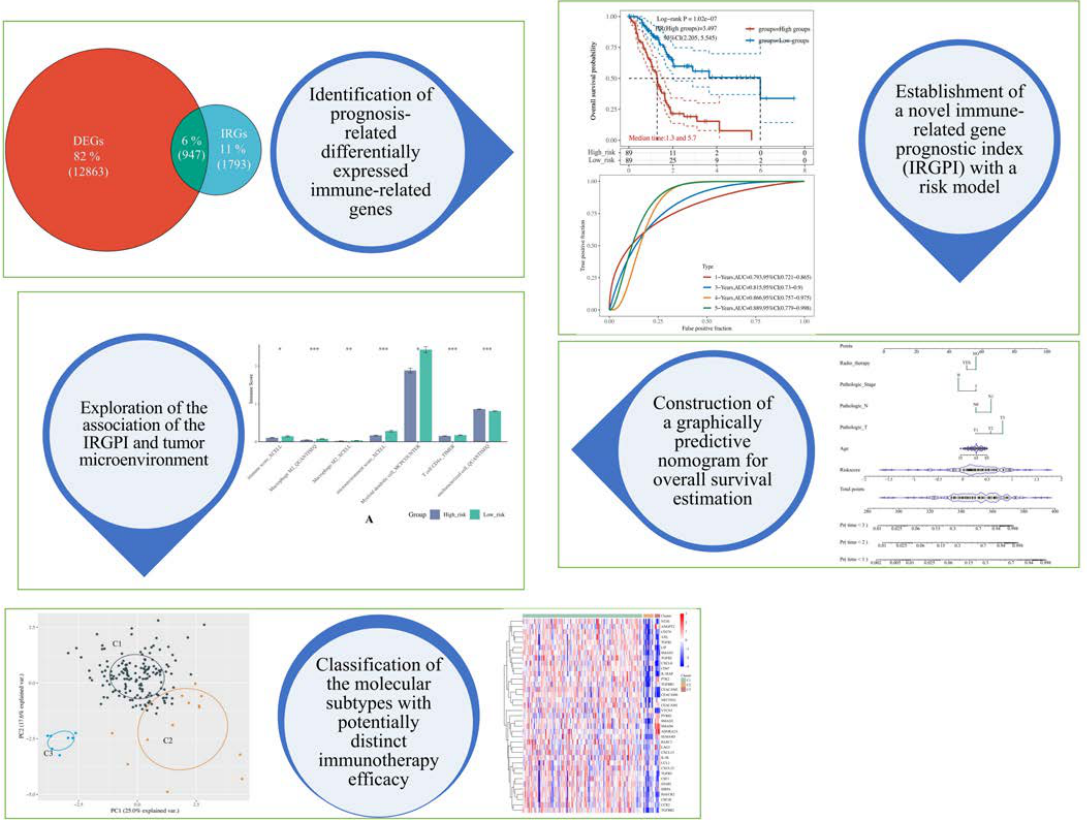
Figure 1. The graphical abstract of the present study. In this work, we first screened the prognosis- related differentially expressed immune-related genes in pancreatic adenocarcinoma (PAAD) to se- lect feature genes (i.e., the 12 genes within the immune-related gene prognostic index) to construct a machine learning model. Then, we compared its predictive performance with previous models derived from ferroptosis and pyroptosis, finding that our model performed better. Next, we inte- grated other clinical factors such as age, pathological stage, as well as others to build a nomogram so that clinicians could use it graphically. Afterward, we explored the potential relationship be- tween our model and the tumor microenvironment. Finally, we used unsupervised clustering to classify PAAD patients into 3 more precise molecular subtypes according to the expression of the IRGPI genes. * p < 0.01, ** p < 0.001, *** p < 0.0001. 2. Materials and Methods 2.1. Data Acquisition and Processing The RNA-seq data and corresponding clinical information of TNBC patients were downloaded from The Cancer Genome Atlas (TCGA) cohort (https://www.ge- nome.gov/Funded-Programs-Projects/Cancer-Genome-Atlas (accessed on 18 March 2022)), International Cancer Genome Consortium (ICGC) data portal (https://dcc.icgc.org/ (accessed on 18 March 2022)), and Gene Expression Omnibus (GEO) database (https://www.ncbi.nlm.nih.gov/geo/ (accessed on 18 March 2022)). The well-organized data was divided into a TCGA training set ( n = 177), an ICGC validation set (from Aus- tralian patients, n = 269), and a GEO validation set (from the GSE62452 dataset, n = 130) [22,23]. Additionally, 54 non-tumorous samples from the Genotype-Tissue Expression (GTEx) project (https://gtexportal.org (accessed on 18 March 2022)) and unique immune- related genes (IRGs) from the ImmPort database (https://www.immport.org (accessed on